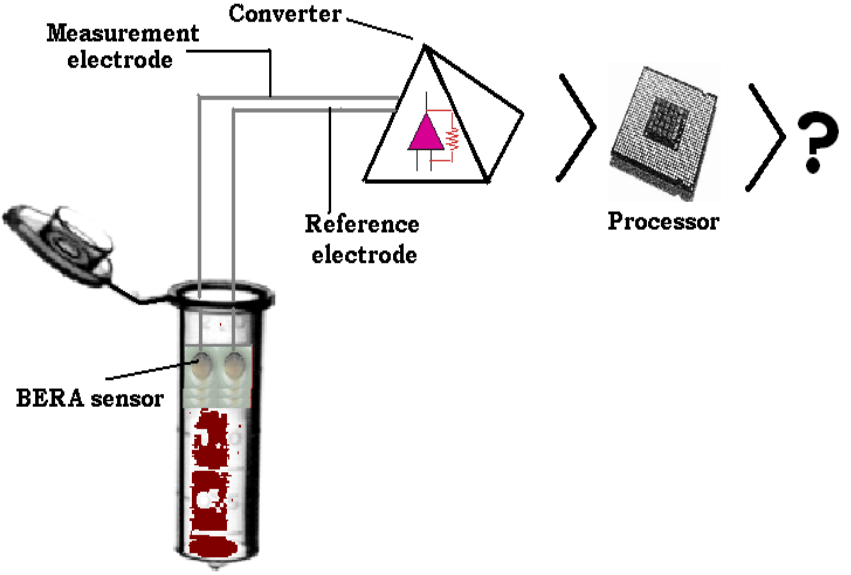
Figure 1. Schematic representation of the immobilized cell biosensor. The reference electrode is manually inserted in a cell-free gel bead, while the measuring electrode is inserted in the immobilized cell-loaded gel bead. Neither electrode is in direct contact with the sample solution (i.e. only beads are immersed into sample). The approximate diameter of the beads is two mm. Both measurement and reference electrodes are connected to the PMD 1608-FS